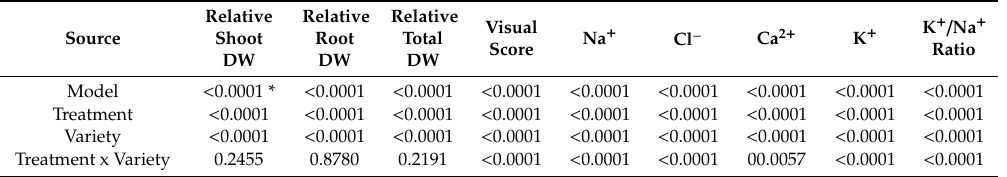
Figure 1. Mean electrical conductivity (EC) of leachate throughout the experiment. Six random containers per treatment were measured on a weekly basis. Bars represent standard deviation. Table 1. Analysis of Variance (ANOVA) summary of all response variables measured from four varieties of perennial ornamentals irrigated with control or saline solutions for eight weeks.